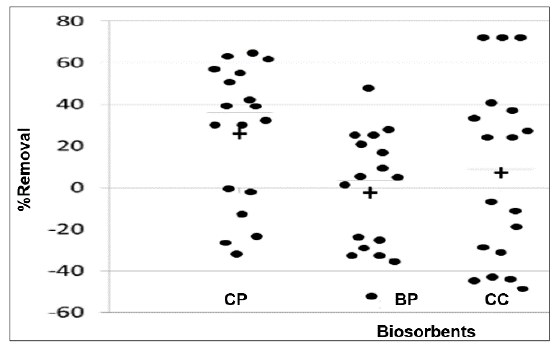
Figure 5. Scattergram of the three agricultural wastes.